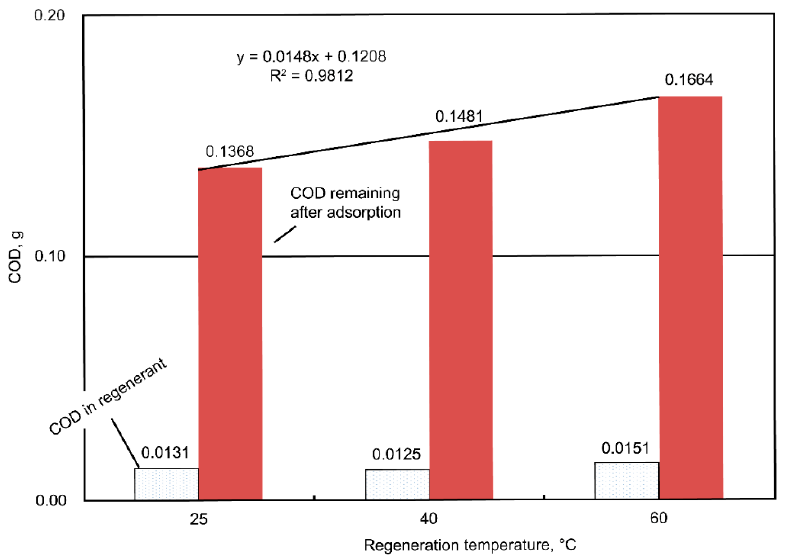
Figure 7. Plots of the COD residues (by weight) in the regenerant and the amounts of remaining COD in the AC-treated wastewater under various regenerating temperatures and a fixed pH value of 4.7. The lower the regeneration temperature, the less COD remained after adsorption.